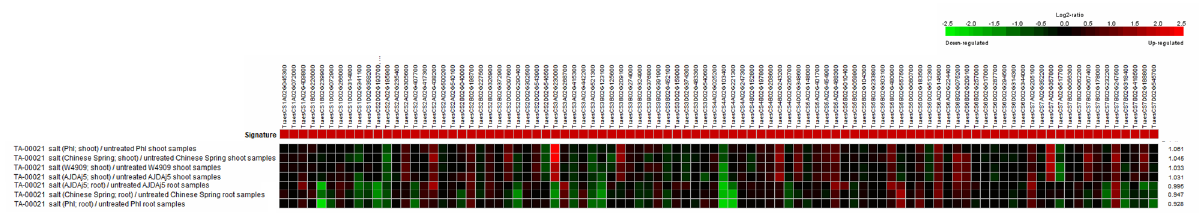
Figure 5. RNA-seq based salt stress-specific expression profiles of salt stress responsive genes in wheat. The expression datasets were normalized and presented as heat maps using meta-analysis tool. The intensity of color represents the percent expression profile of the genes as described in the legend